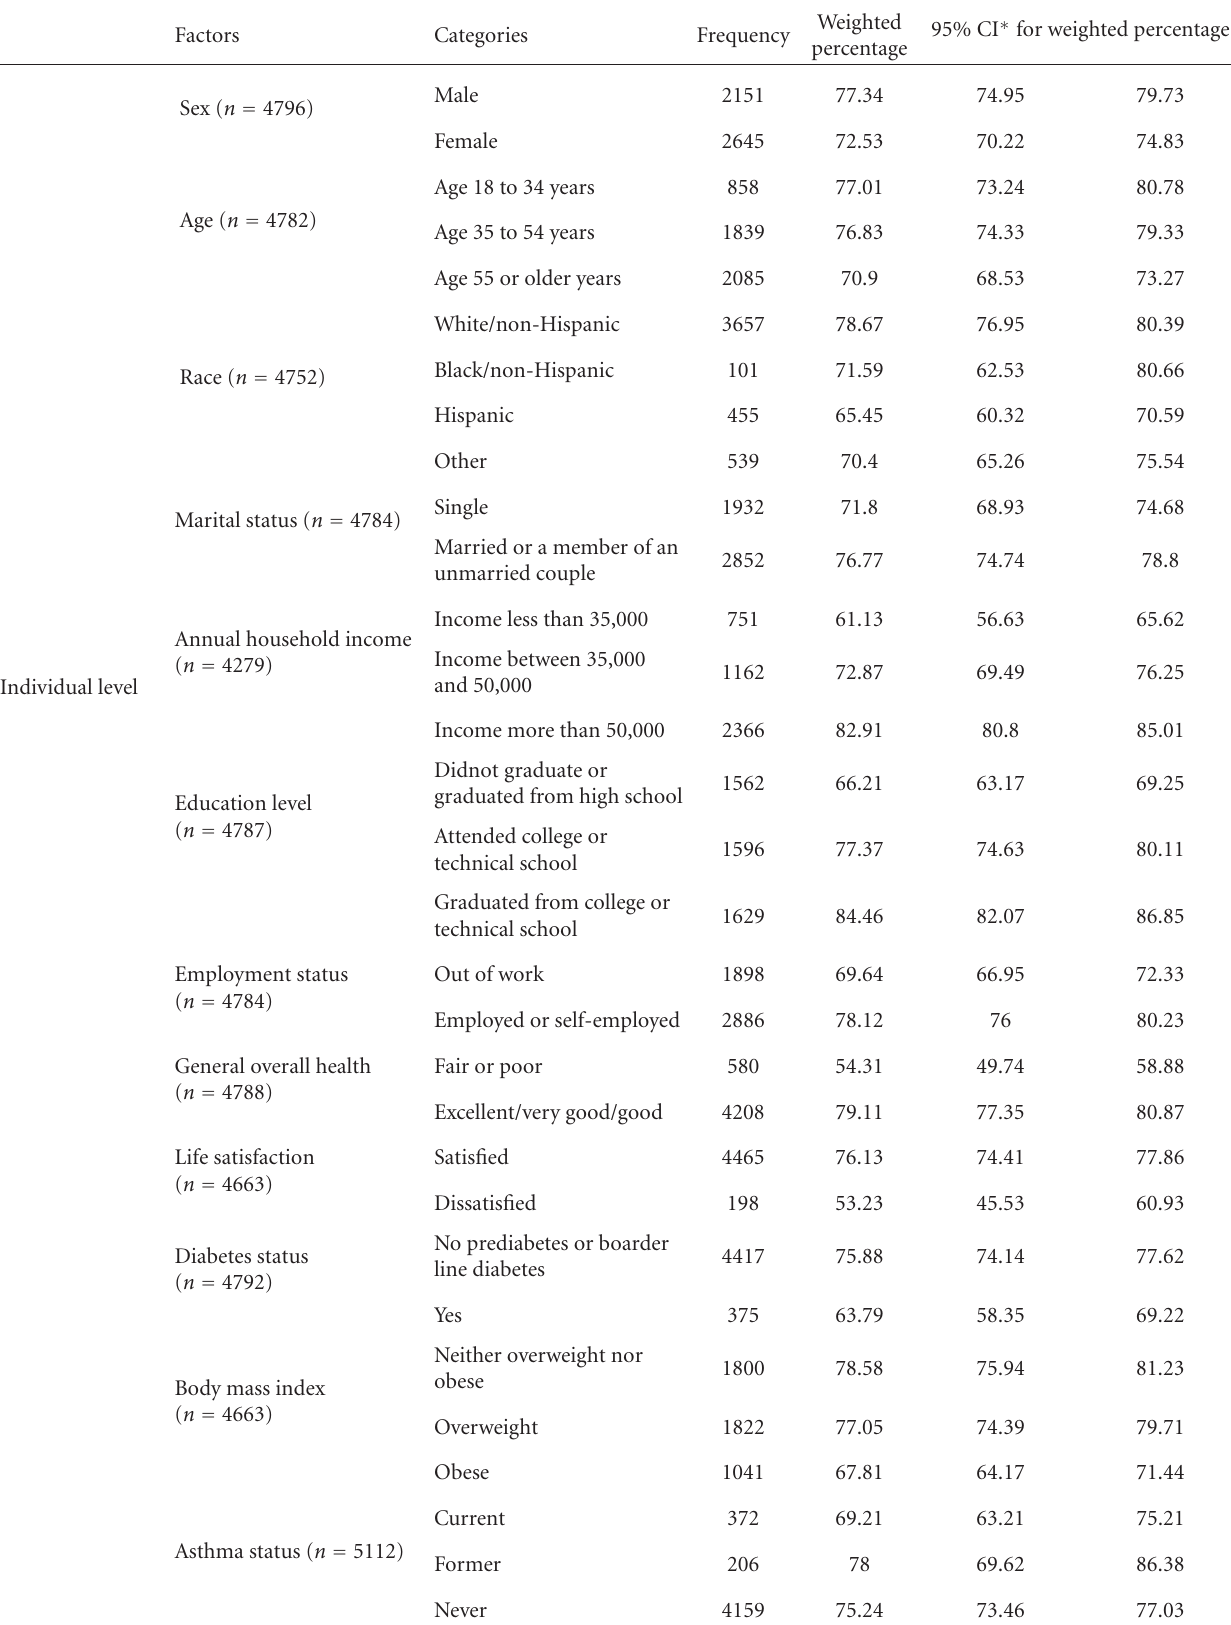
Table 2: Weighted prevalence of potential factors related to conducting physical